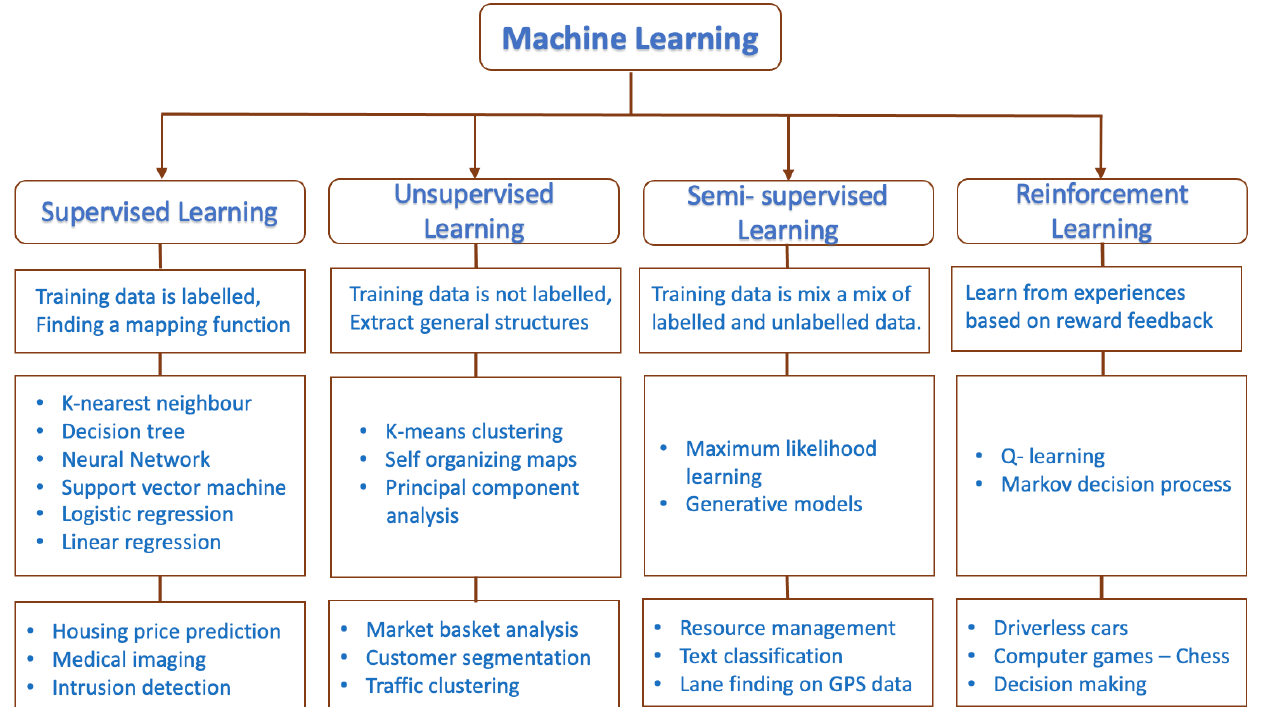
Figure 8. Machine learning